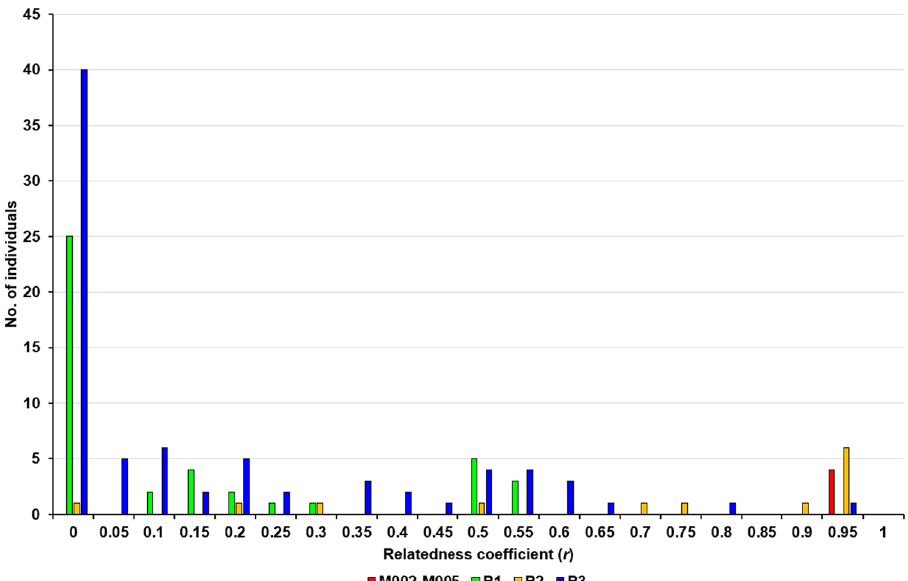
Figure 5. Histogram of coefficients of relatedness (r) based on 15 polymorphic microsatellites between the M001 genotype and all other analyzed